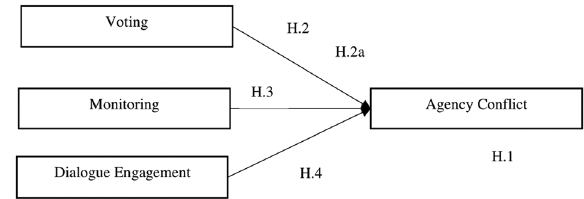
Fig. 2 Conceptual framework and hyphoteses of study.